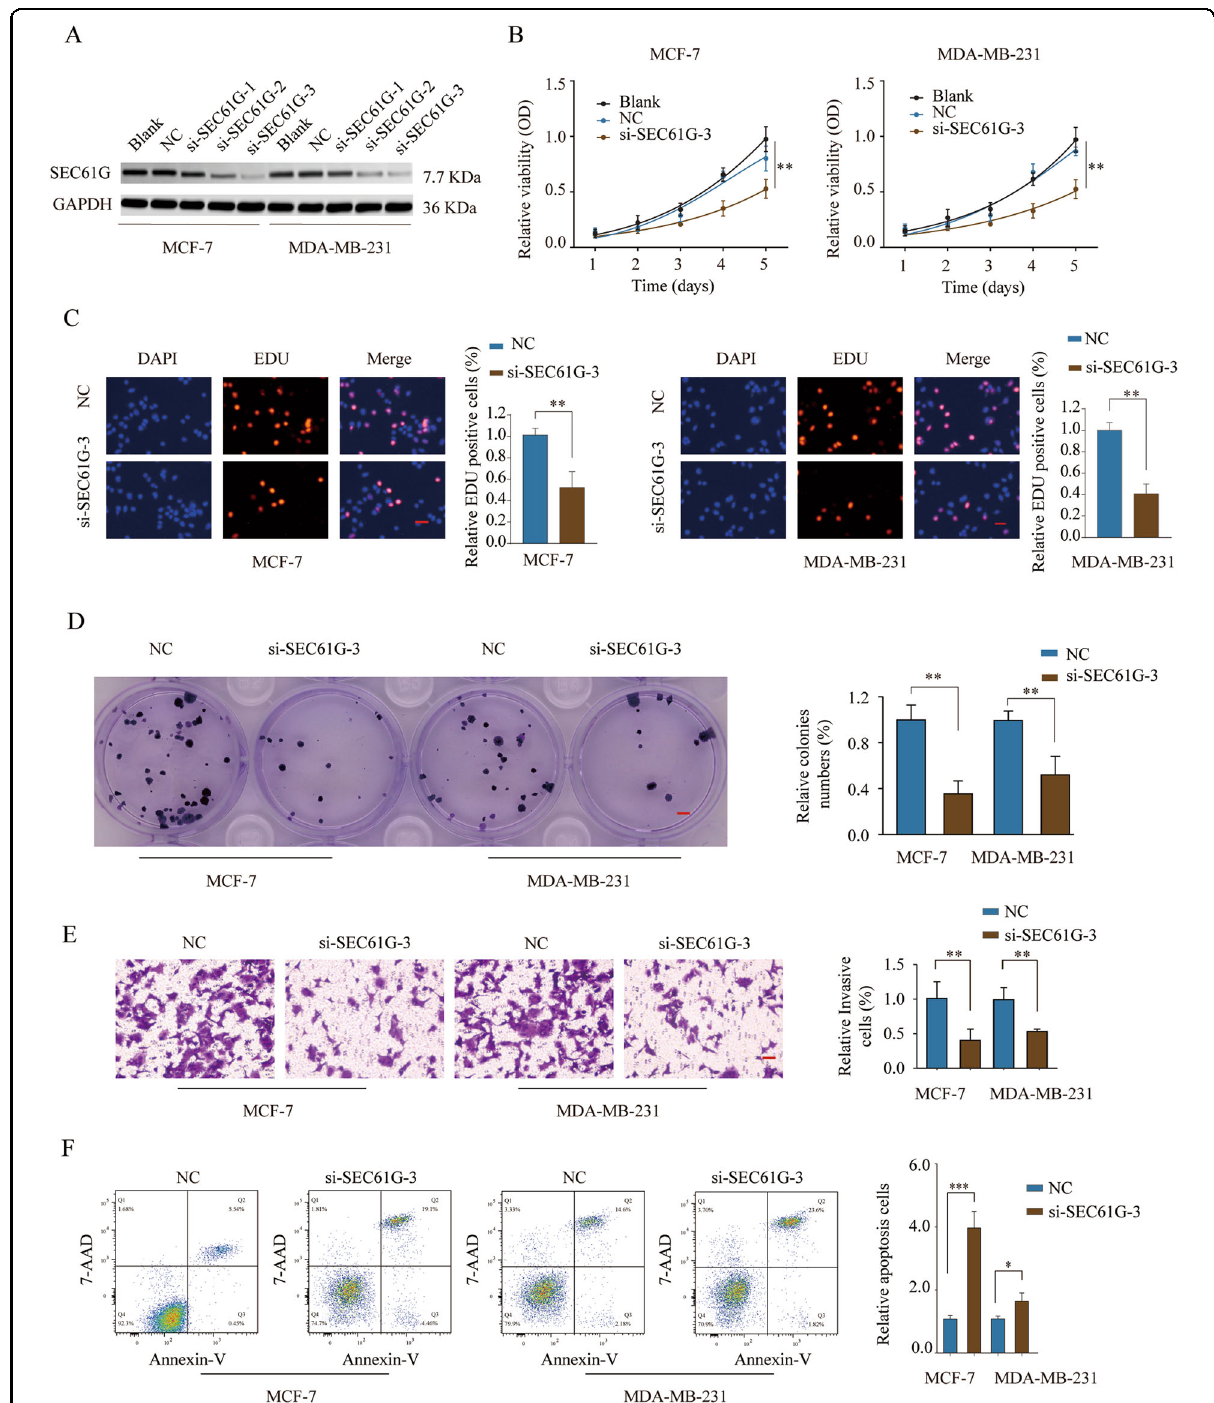
Fig. 3 Knockdown of SEC61G suppresses breast cancer cell proliferation, migration, invasion, and promotes breast cancer cell apoptosis in vitro. A MCF-7 or MDA-MB-231 cells were left untreated (Blank), or transfected with negative control (NC) or siRNAs targeting SEC61G. The relative protein expression of SEC61G in MCF-7 or MDA-MB-231 cells was analyzed by western blot. B – D MCF-7 or MDA-MB-231 cells were left untreated or transfected with NC or si-SEC61G-3. B Cell proliferation was analyzed by CCK-8 assay at the indicated time points. C DNA synthesis was analyzed by the EDU incorporation assay. D Cell growth was assessed by colony formation assay. E Cell invasion was assessed by transwell assay. F Cell apoptosis was analyzed by Annexin V/7-AAD double staining. * P < 0.05, ** P < 0.01, *** P <